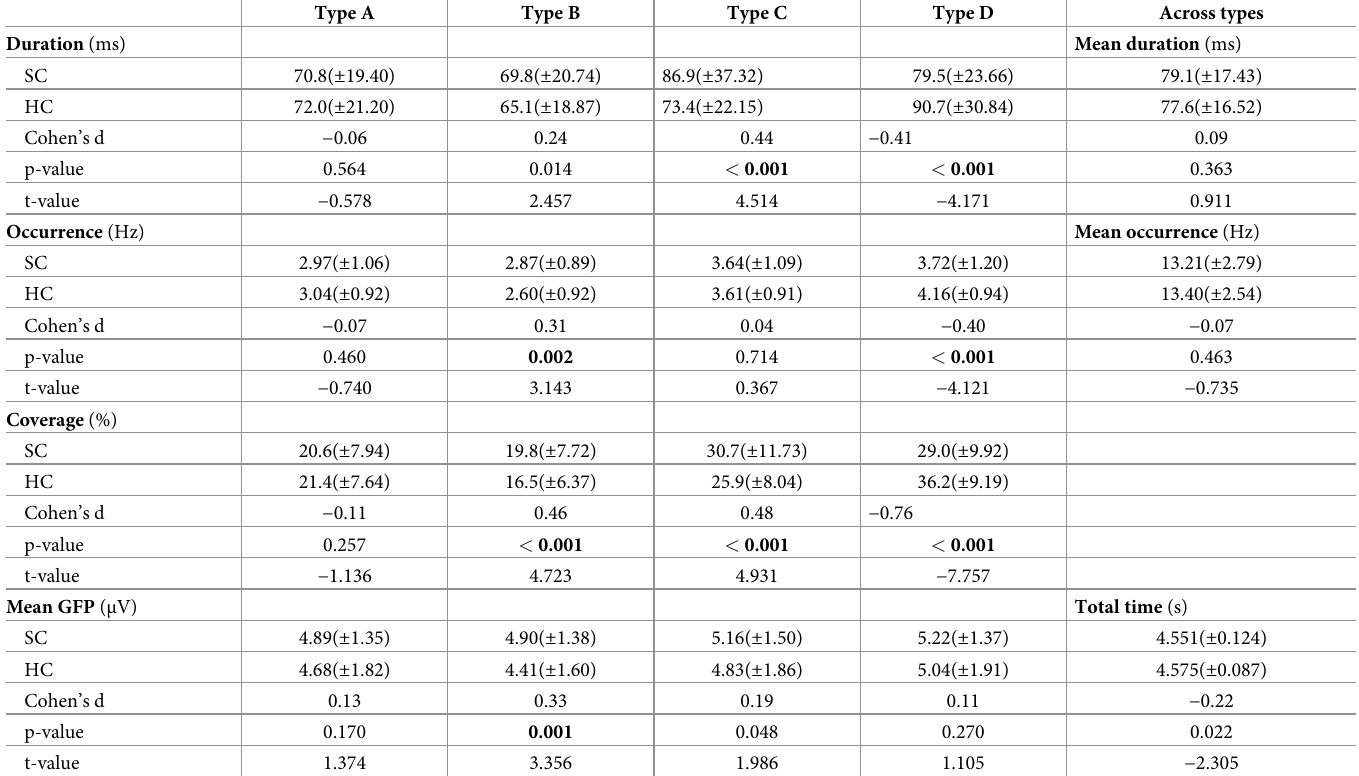
Table 2. 19 microstate features obtained for patients diagnosed with schizophrenia and healthy (control)